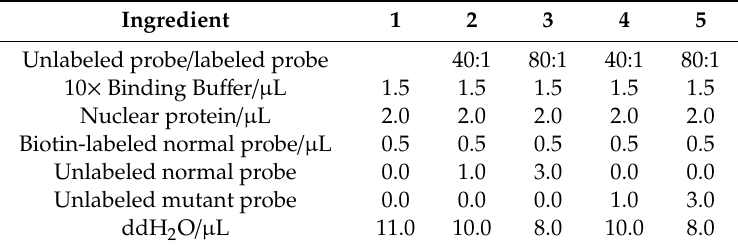
Table 7. Cold-competitive EMSA reaction